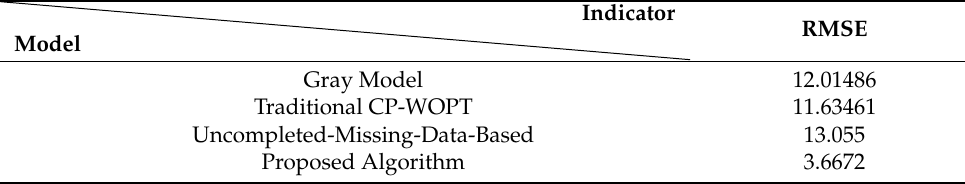
Figure 8. Prediction results. (a) Morning peak prediction; (b) Noon peak prediction; (c) Evening peak prediction. Table 2. Comparison of prediction accuracy.